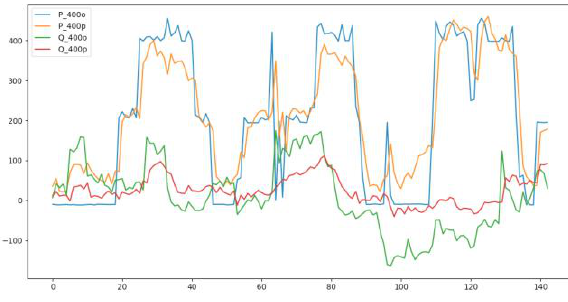
Fig. 9. The result of prediction is close to real data. Number of predicted parameters is 6.